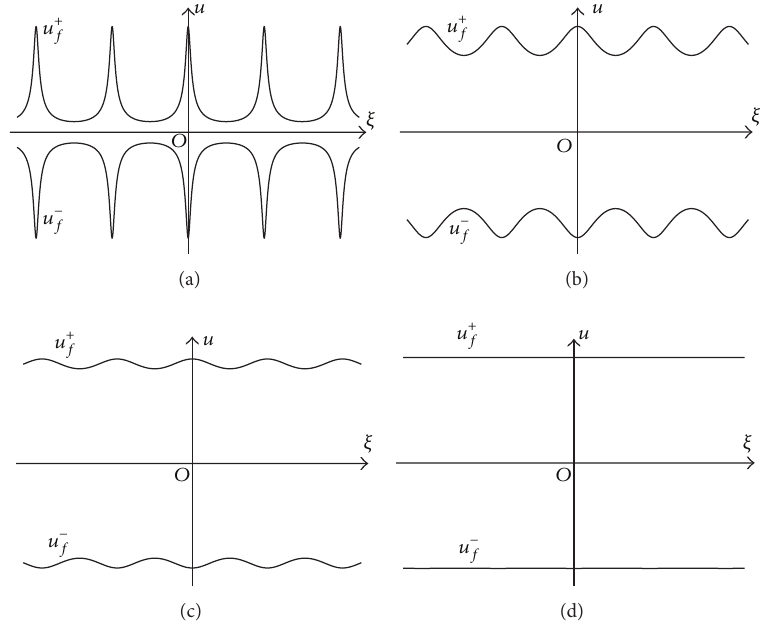
Figure 10: The periodic waves become the trivial waves. The varying process for the figures of 𝑢 ± 𝑓 when (𝑎,𝑏) ∈ 𝐴 2 and 𝑏 → −(5𝑎 2 /48𝑐) + 0 , where 𝑐 = 𝑎 = 1 , 𝛾 = 𝛿 = −1 , and (a) 𝑏 = −(5𝑎 2 /48𝑐)+10 −1 , (b) 𝑏 = −(5𝑎 2 /48𝑐)+10 −2 , (c) 𝑏 = −(5𝑎 2 /48𝑐)+10 −3 , and (d) 𝑏 = −(5𝑎 2 /48𝑐)+10 −7